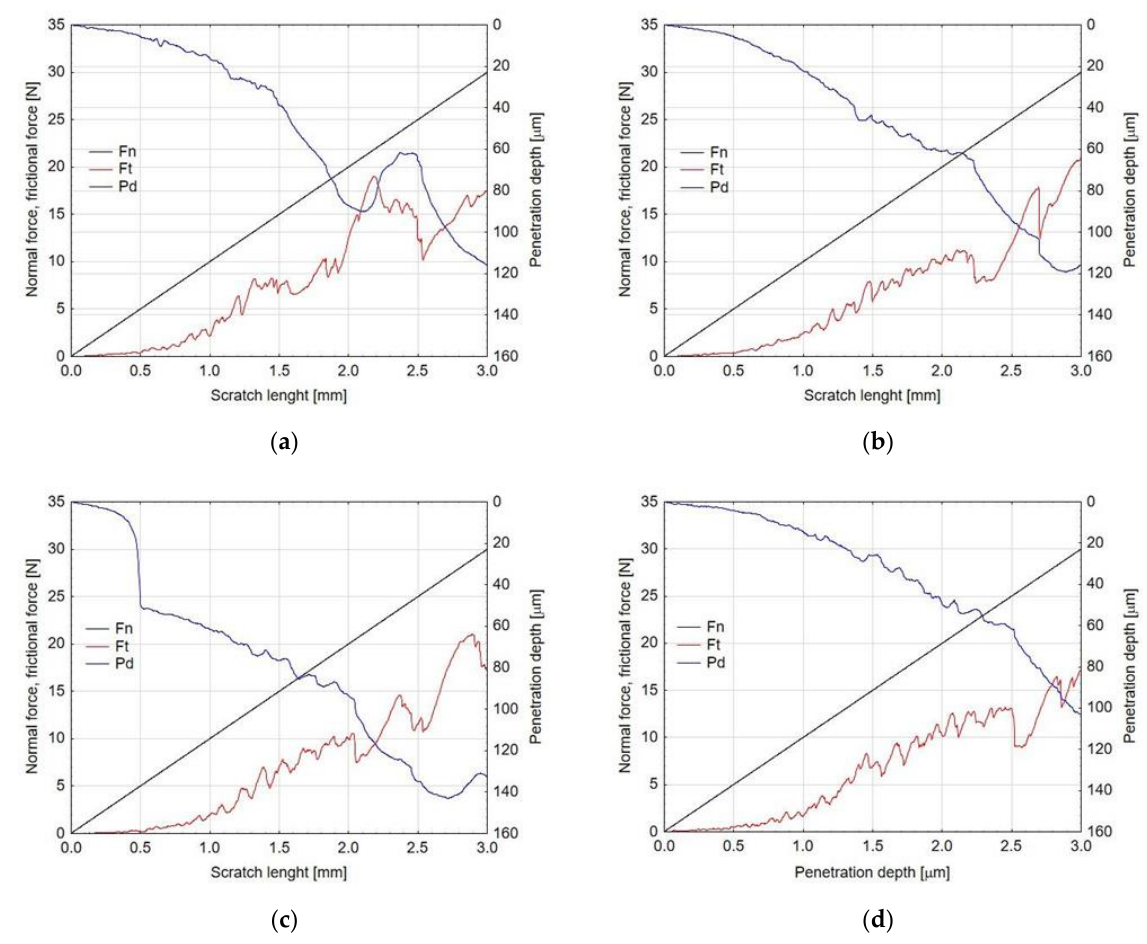
Figure 5. Characteristics of scratch test parameters ( a ) Sample 1, ( b ) Sample 2, ( c ) Sample 3, ( d ) Sample 4; F n –normal force, F t –frictional force, P d –penetration